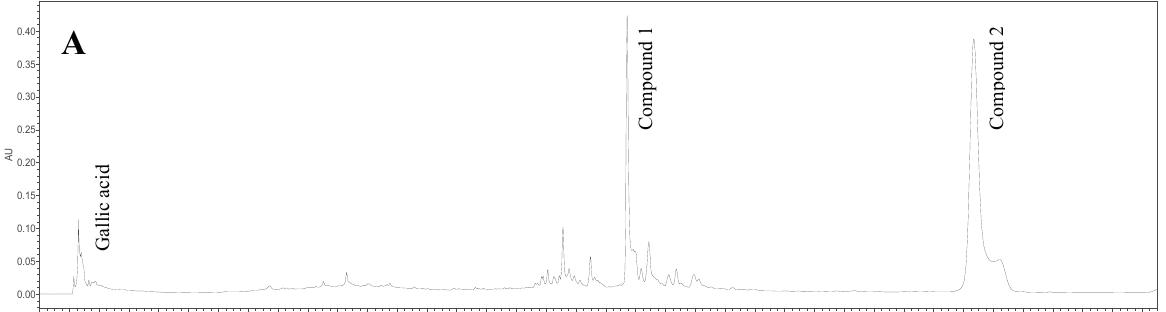
Figure 1. Chemical structures of 5-(Z-nonadec-14-enyl)resorcinol ( 1 ) and demethylbelamcandaquinone B ( 2 ).